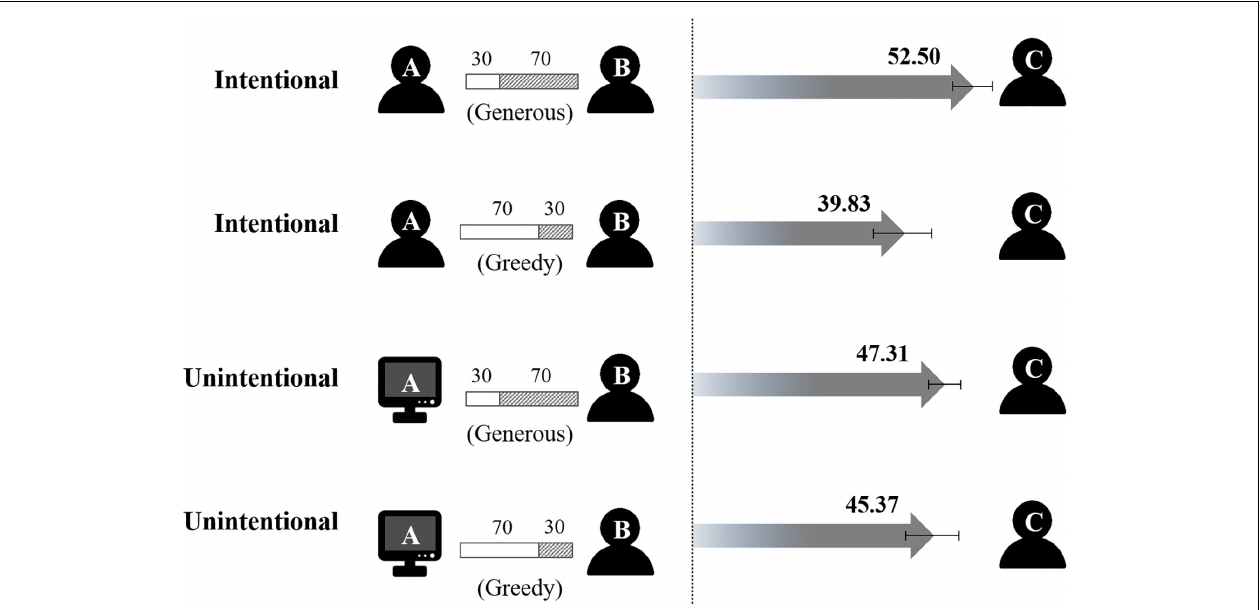
FIGURE 2 | The manipulation of the treatments in the first round of dictator game and results in Experiment 1. The number above gray arrow represents the average number of tokens allocated to player C among total 100 tokens, and the error bar represents one